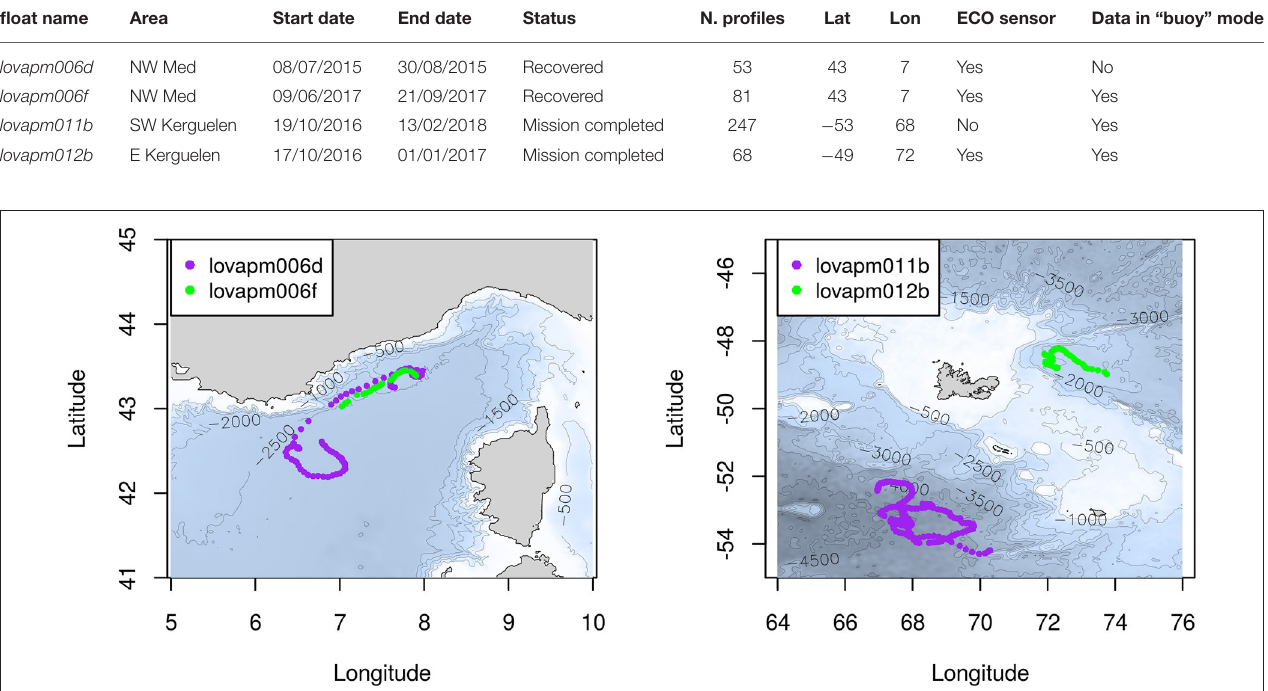
to be “regularly < 5 ◦ from the vertical” (Morrow et al.,